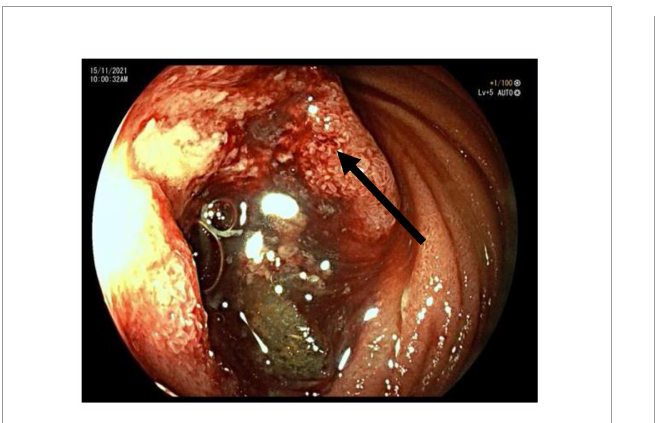
FIGURE 2 | Endoscopic image of the tumor. FIGURE 3 | H&E stain X100. Arrow points mucin producing malignant